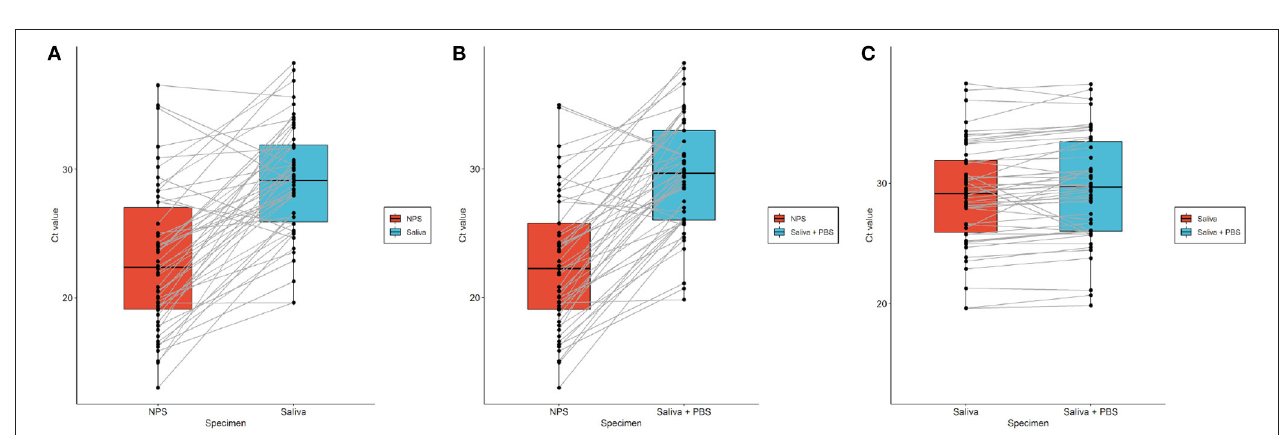
FIGURE 3 | Boxplot for paired Ct values between NPS and Saliva (A) ; NPS and Saliva + PBS (B) ; and Saliva and Saliva + PBS (C) . Chart shows Ct values (black dots) obtained from NPS, Saliva and Saliva + PBS specimens paired with each other (gray lines) for each participant, along with boxplot and median marked as solid black line within each